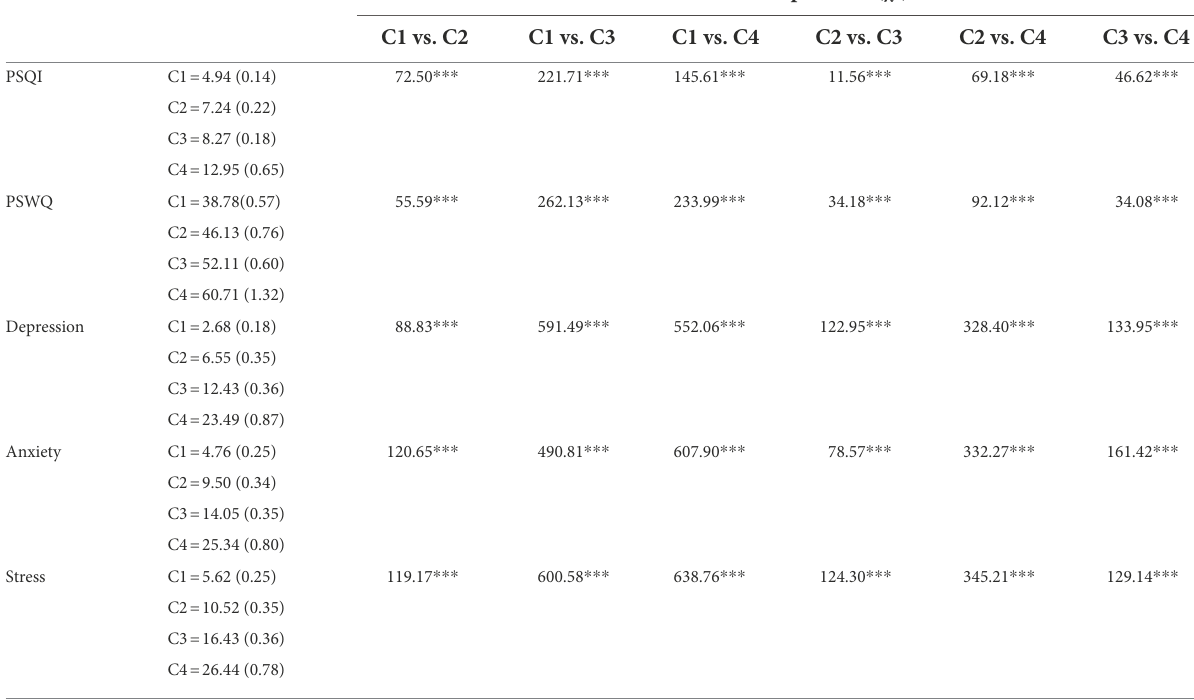
TABLE 4 Parameter estimates of cognitive vulnerabilities and psychological symptoms on the four profiles, M ( SE